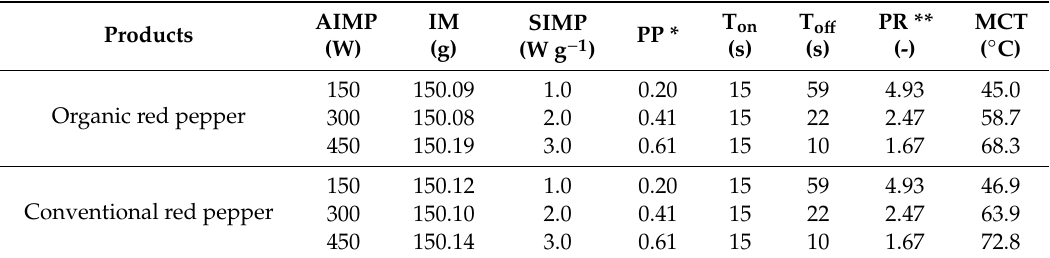
Table 1. Applied intermittent microwave power and related parameters used in the drying experiments of organic and conventional red peppers.